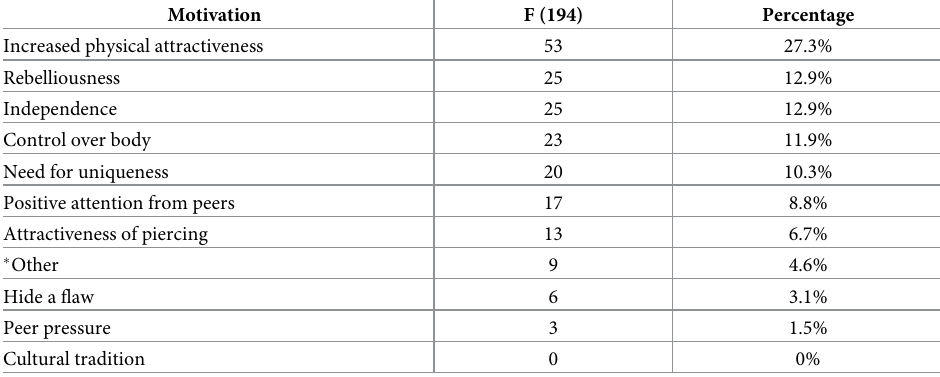
Table 1. List of motivations ranked from the most common to the least common. � Other refers to answer akin to ‘simply wanted one’ or ‘impulsive decision’. F means the total amount of reasons selected by the participants, as each participant could select more than one